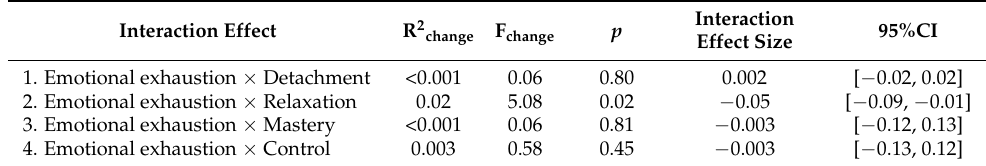
Table 3. Testing the moderating effects of recovery experiences on the relationship between emotional exhaustion and gaming addiction.